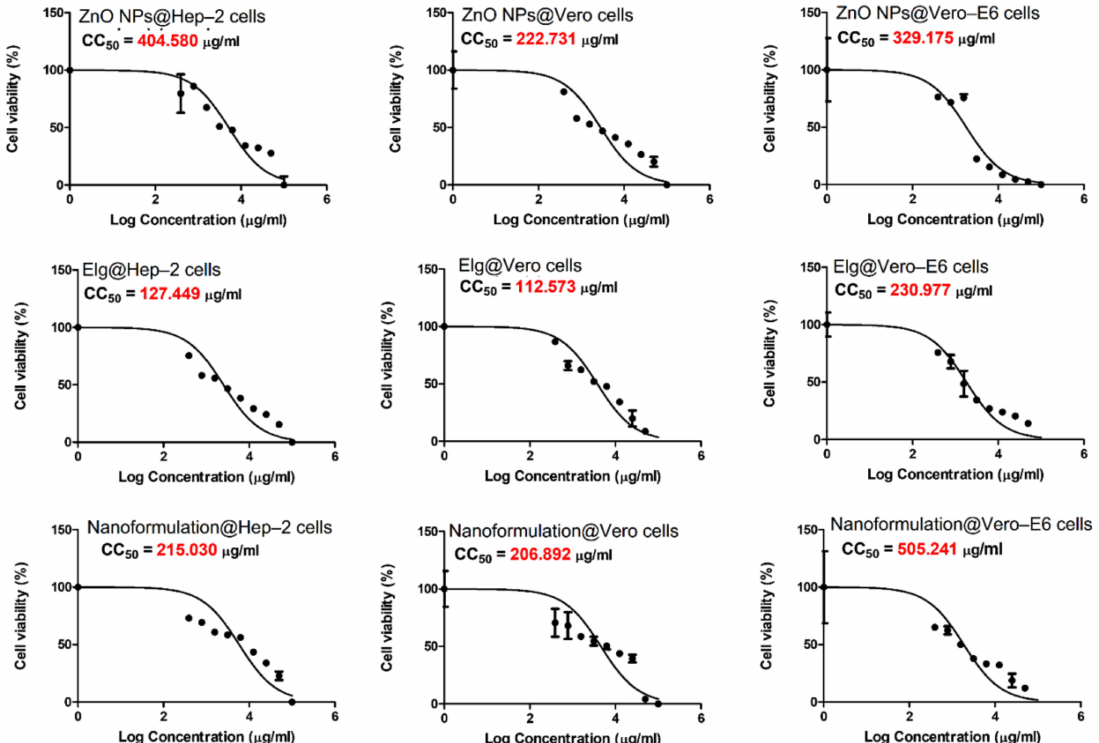
Figure 8. The cytotoxic effects (CC50) of tested materials against three cell lines for the investigated viruses: Hep–2 cells, Vero cells, and Vero–E6 cells. Each graph was obtained by nonlinear regression analysis. We plotted log concentrations against cell viability normalized